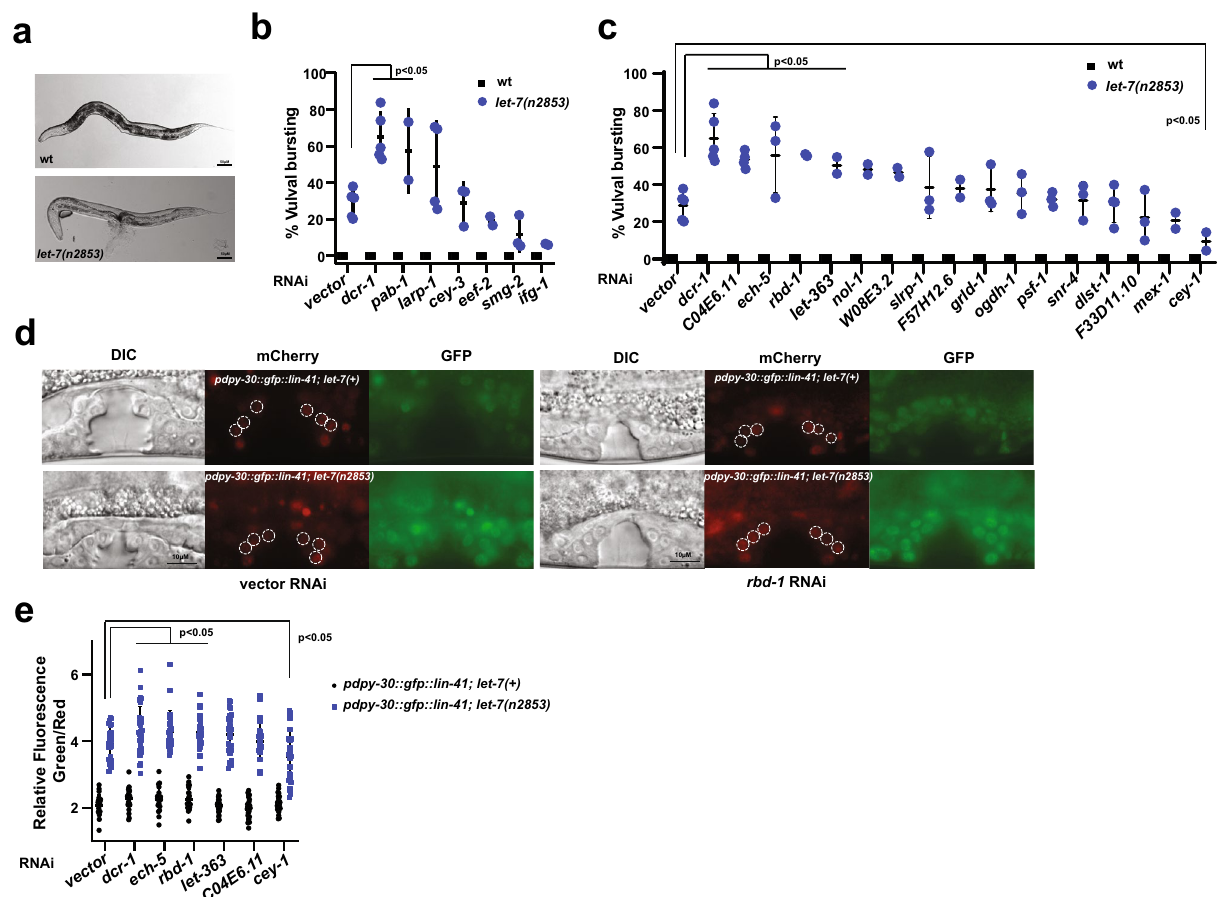
Figure 3. RNAi knockdown of genes encoding ALG-1 and let-7-associated factors genetically modifies let-7(n2853) vulval bursting phenotype. ( a ) let-7(n2853) mutants show partially penetrant vulval bursting phenotype at 15 °C. RNAi of ( b ) genes of previously reported conserved interactors of AGO 19 and ( c ) let- 7-precipitated factors in wild type and let-7(n2853) mutants. Each dot represents an independent RNAi experiment. Statistical significance was determined by one-way ANOVA with post hoc Bonferroni correction. ( d ) Effects of vector and rbd-1 RNAi on pdpy-30::gfp::lin-41 3 ′ UTR reporter expression in the vulval cells of wild type and let-7(n2853) L4 larvae. Compromised miRNA activity in let-7(n2853) background leads to de-repression of pdpy-30::gfp::lin-41 3 ′ UTR reporter expression levels (quantified in e ). ( e ) RNAi of genes of modifiers of let-7(n2853) vulval bursting phenotype affects pdpy-30::gfp::lin-41 3 ʹ UTR reporter expression levels in let-7(n2853) background. Each dot represents the relative intensity in an individual worm. Vulval precursor cells used for fluorescence quantification are highlighted with dashed circles. T-test was used to determine statistical significance. Vector = empty vector RNAi